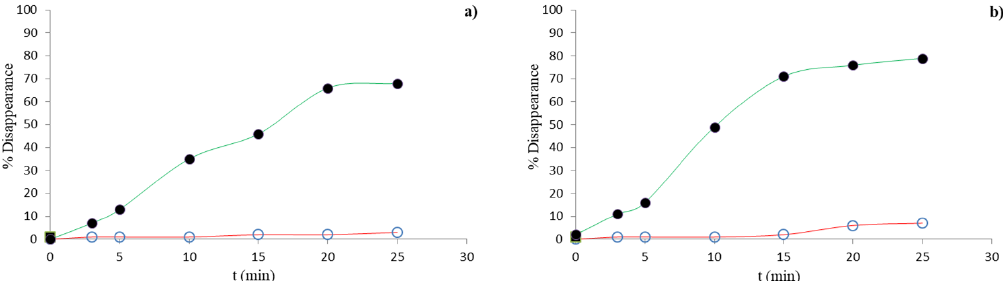
Figure 1. Time-conversion plot for the reaction of amoxicillin (AMO) with one equivalent NaOCl at buffered pH = 3.0 ( a ) pH = 7 ( b ). • : AMO consumption by reaction with NaOCl (green); and pH = 7 ( b ). ● : AMO consumption by reaction with NaOCl (green); ○ : Disappearance of AMO in the absence of NaOCl (red).